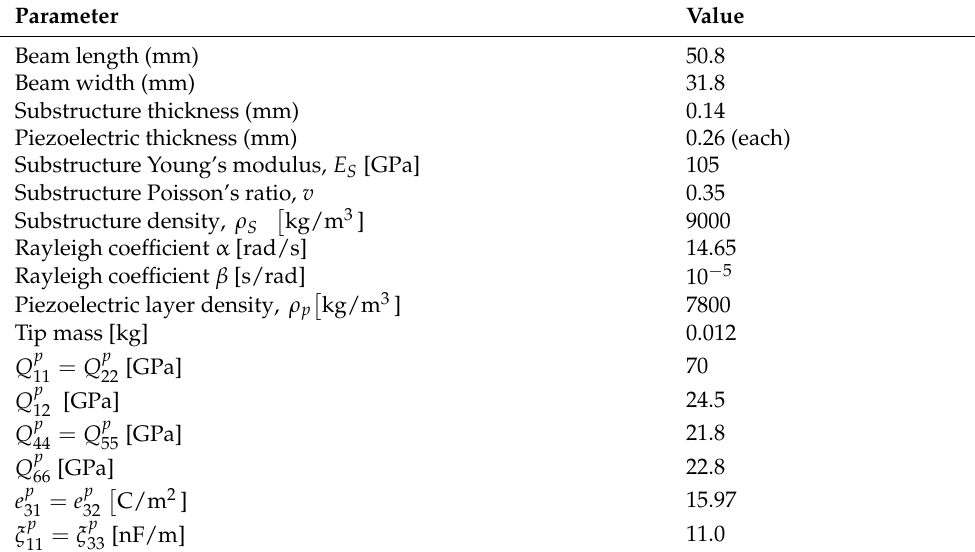
Table 1. Material and geometric parameters of the bimorph PEH with tip